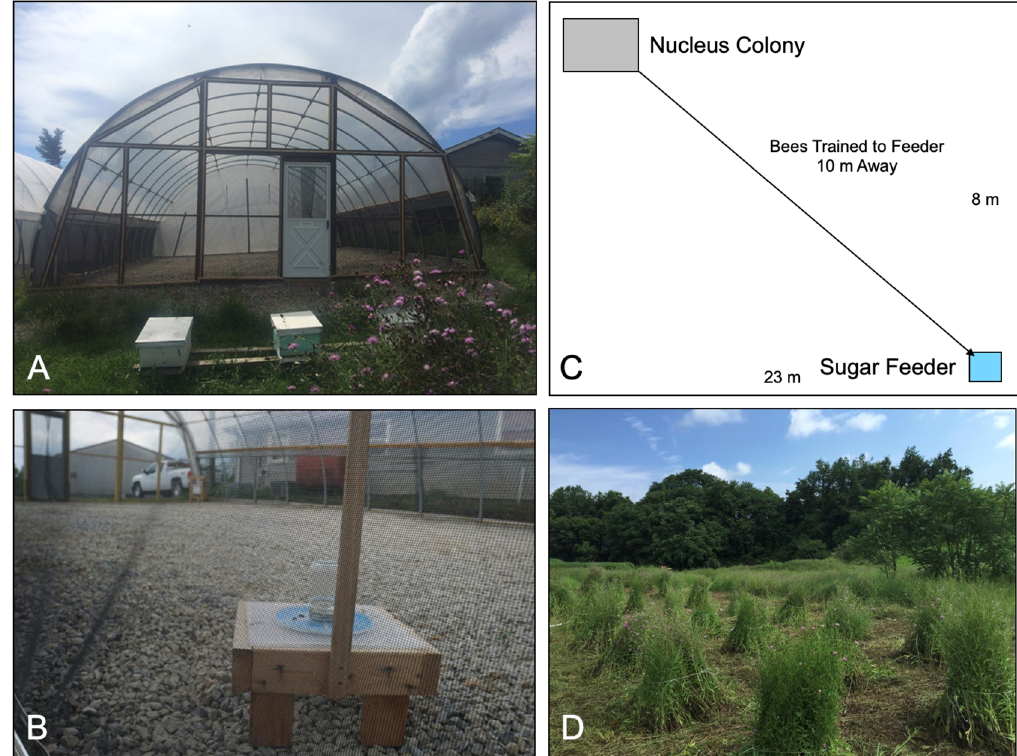
Figure 3. Graphical representation of high-tunnel and knapweed field experiments. Two nucleus colonies were placed into the corner of identical high tunnels ( A ) and the bees were trained to sugar feeders ( B ) located 10 m from the opposite corners of the tunnels ( C ) for 9 days. The sugar feeders were replaced with a sugar solution containing 10 µL/mL piperidine on day 10. Visitation to the feeders was then recorded at 5 min intervals for 1 h using cameras. ( D ) Knapweed bundles sprayed with H 2 O, DEET, or piperidine.